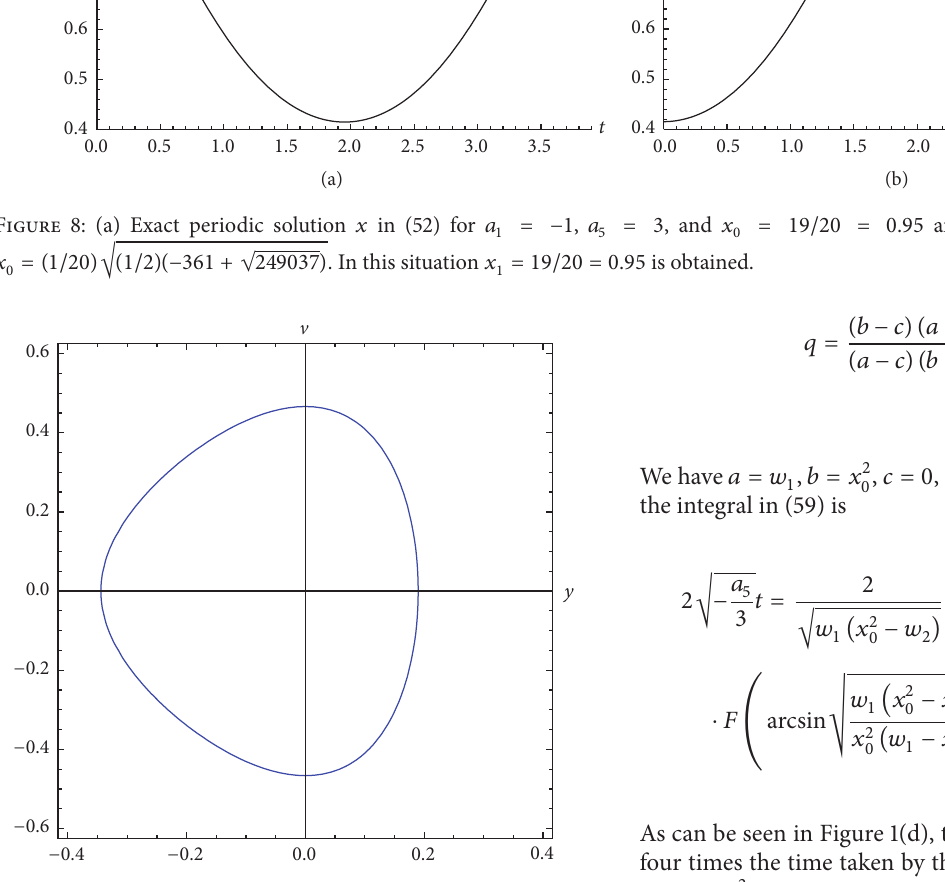
Figure 9: Phase space portrait for the mixed-parity nonlinear oscillator in (56) when 𝑎 1 = −1 , 𝑎 1 = 3 and 𝑦 0 = 𝑥 0 − (−𝑎 1 /𝑎 5 ) 1/4 = 0.95 − 3 −1/4 ≈ 0.190164 . As can be seen the system oscillates around the equilibrium point 𝑦 = 0